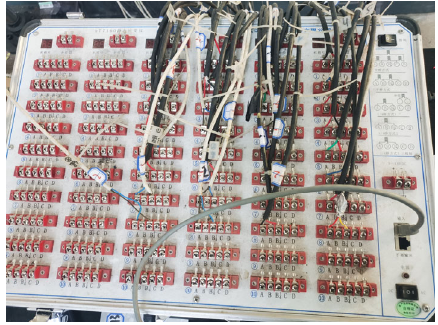
Figure 3. Dimensional drawing of the deviator.